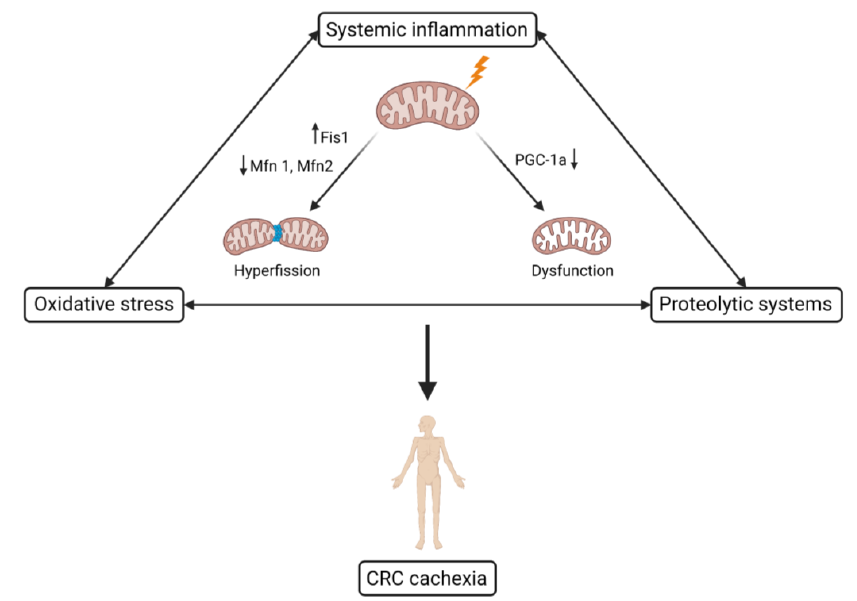
Figure 1. Schematic overview of the underlying mechanisms leading to skeletal muscle mitochondrial dysfunction in colorectal cancer related cachexia. Fis1, mitochondrial fission protein 1; Mfn1, mitofusin 1; Mfn2, mitofusin 2; PGC-1 α , peroxisome proliferator-activated receptor-gamma coactivator 1 α ; CRC, colorectal cancer. Created with Biorender.com (accessed on 26 November